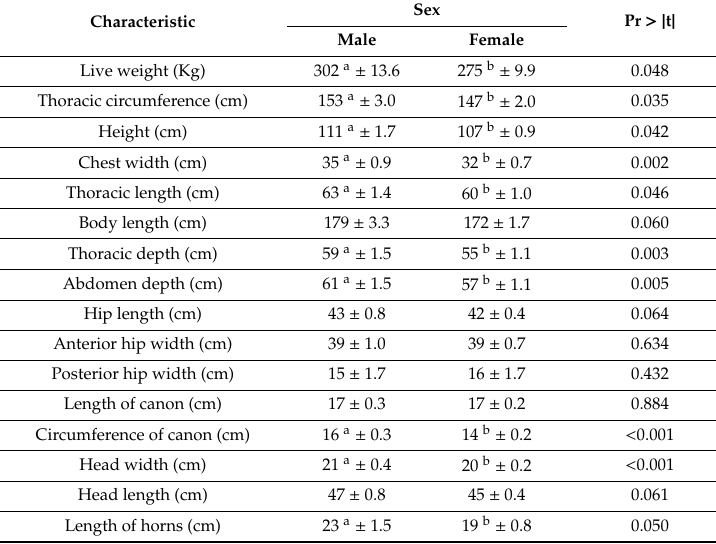
Table 3. Live weight and morphometric characteristics considering the sex of adult Criollo Lojano bovine (mean ± standard error).